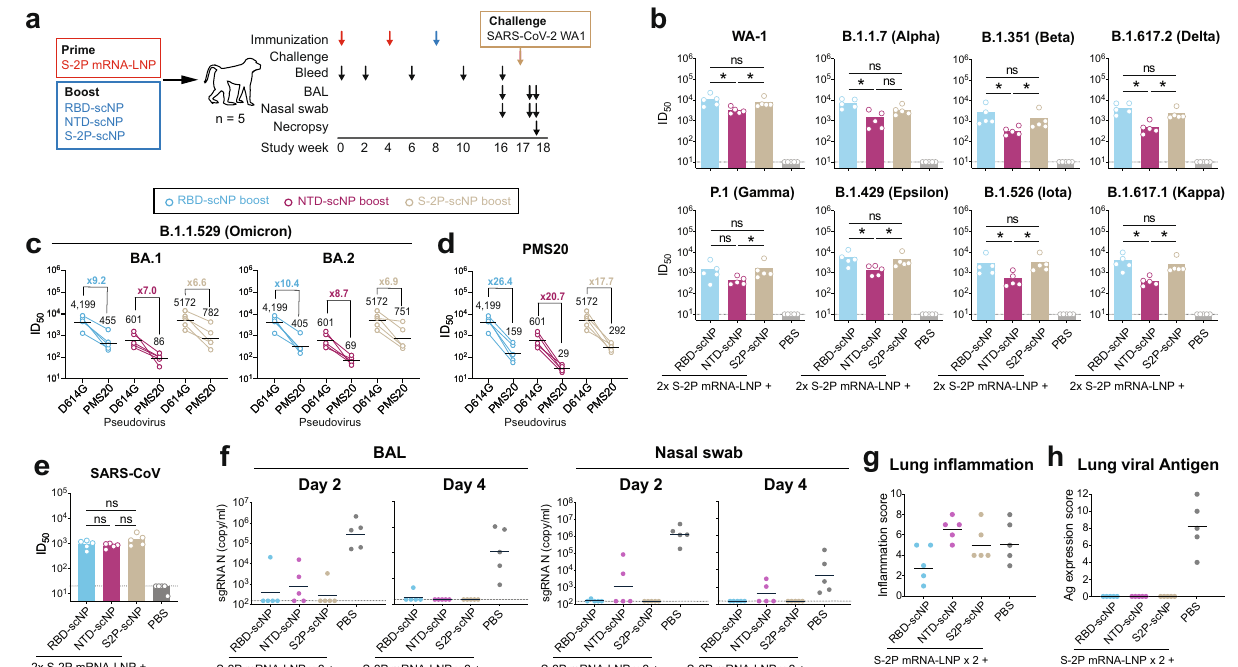
Fig.3|RBD-scNP,NTD-scNPandS2P-scNPvaccinesasaheterologousboostfor the S2P mRNA-LNP vaccine. a Schematic of the heterologous prime-boost